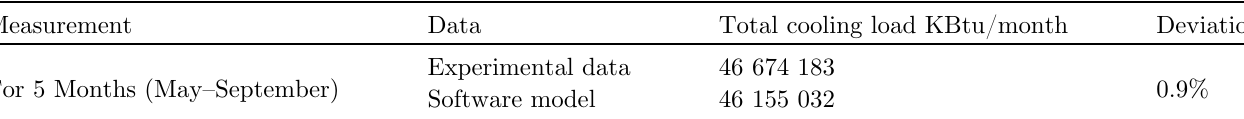
Table 5. Comparison of total load capacity between scenario 1 and scenario